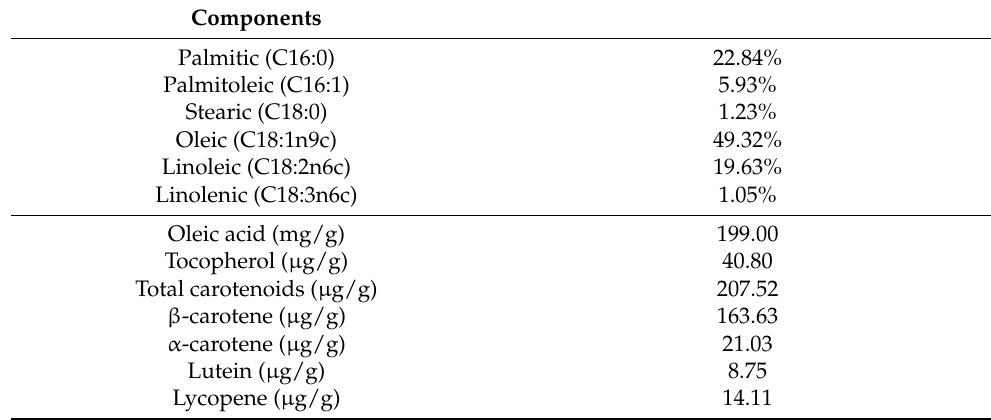
Table 3. Fatty acid profile, carotenoids, and tocopherol contents in macauba pulp oil.